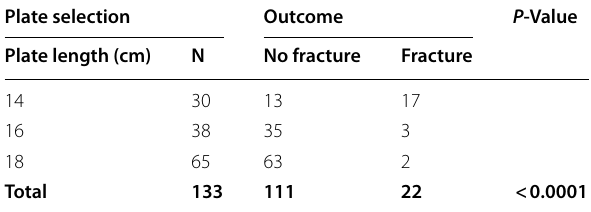
Table 3 Selected plate lengths for all goats included in retrospective radiographic review. Plate length was significantly associated with fracture complication ( p < 0.001) with